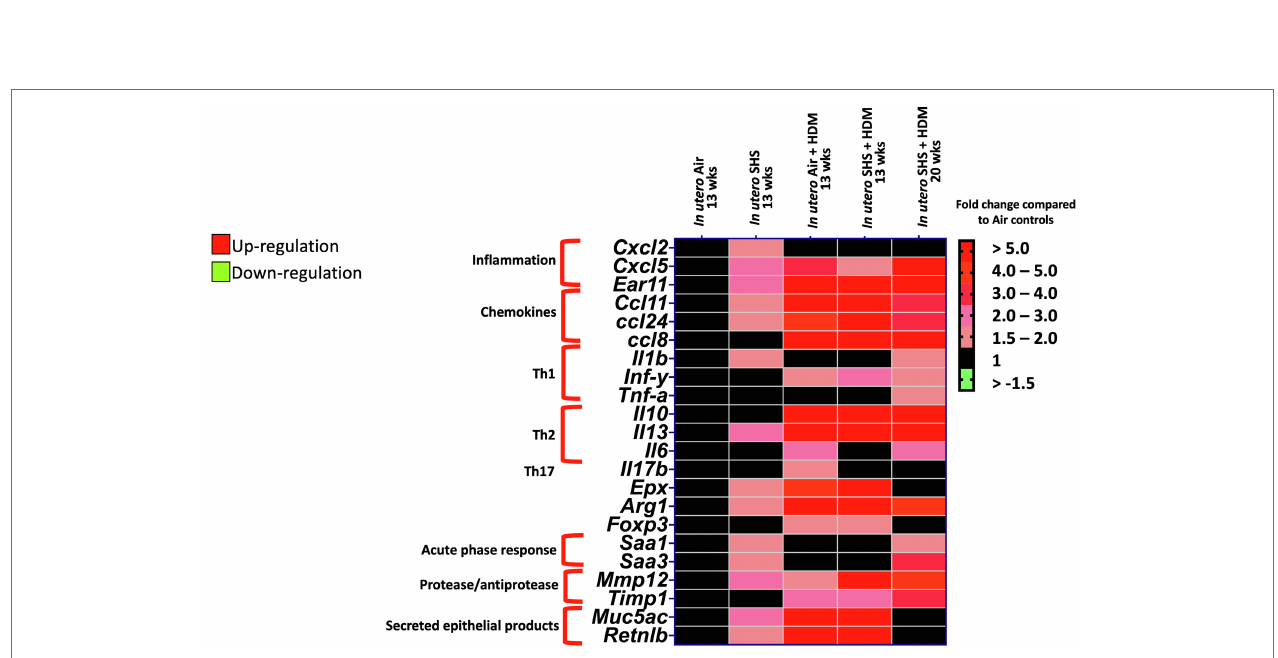
FIGURE 7 | In utero SHS plus adult HDM increased the expression of lung genes involved in chemotaxis and activation of eosinophils. Heatmap displays gene expression data obtained by qRT-PCR from the lungs of 13- and 20-week-old female mouse offspring. N = 9–10 per group. Data are expressed as mean per group. Genes displayed have fold-changes > ±1.5 up-/down-regulation compared to the in utero air plus saline control group and were considered